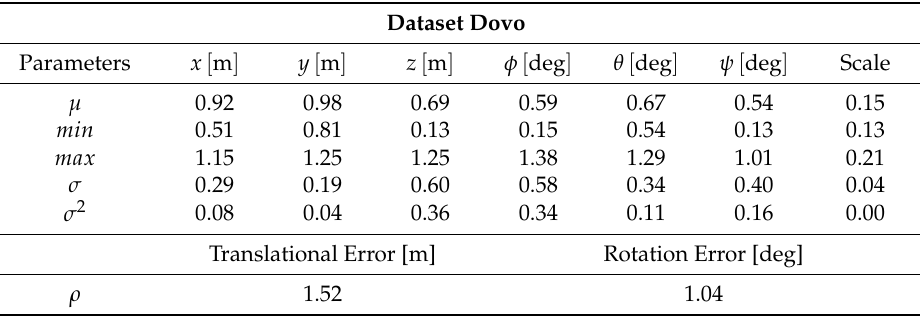
Table 2. Analytical representation of the results with uncertainty in selection of corresponding points (Dataset Dovo)—the error of selected corresponding points is approximately between